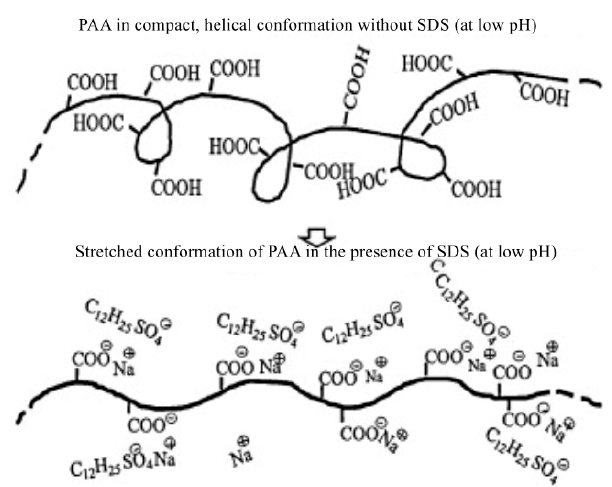
Figure 7. Schematic diagram of the conformational change of the PAA molecule at di ff erent pH levels